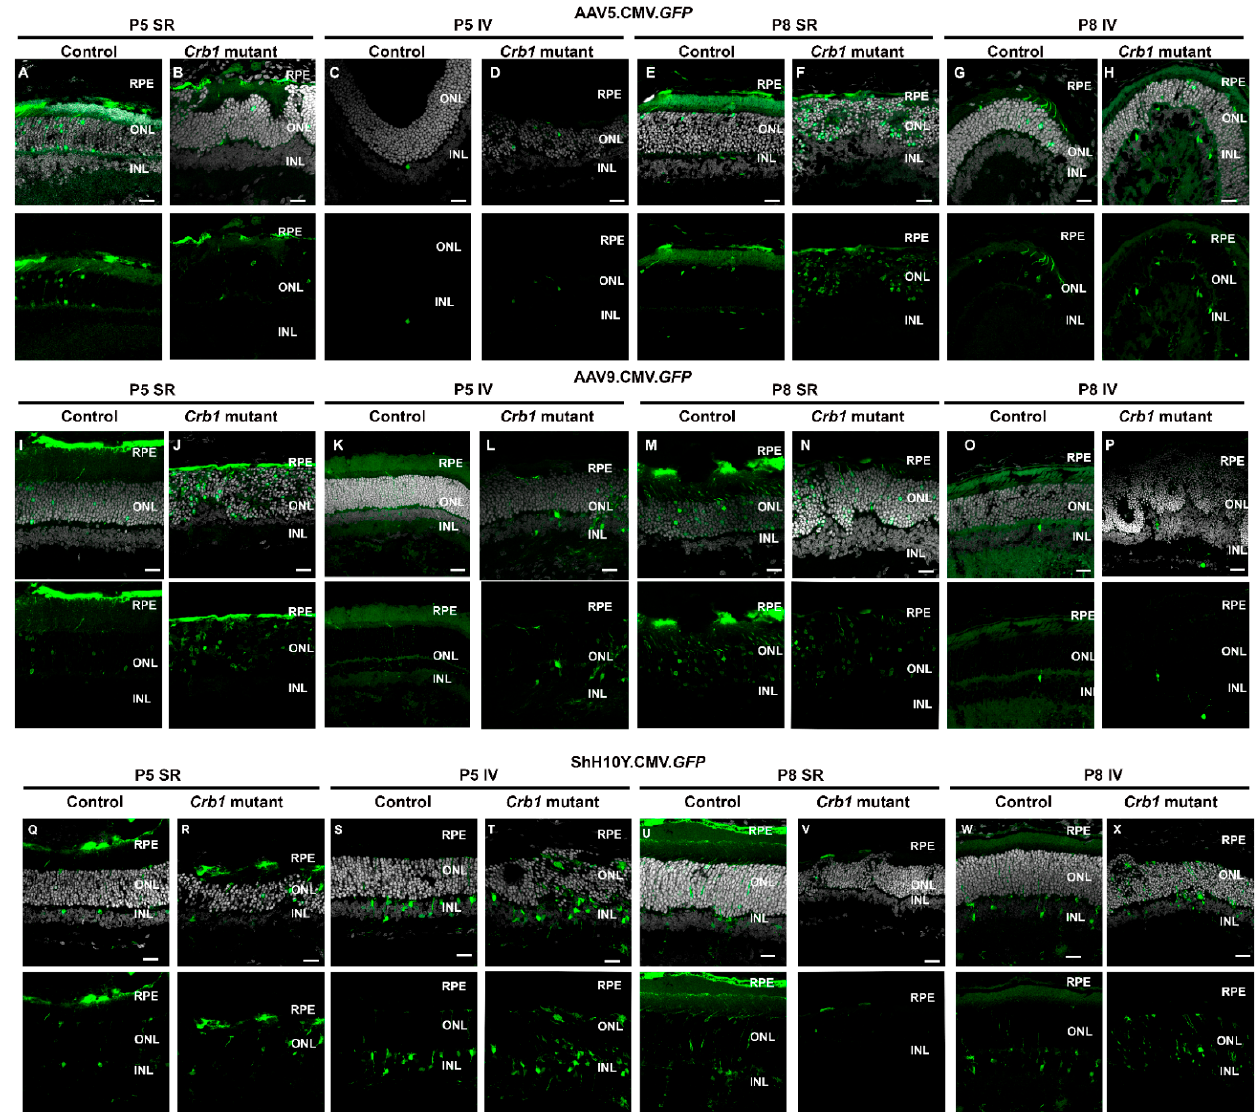
Figure 6. Retinal tropisms of AAV5, AAV9 and ShH0Y in new-born Crb1 mutant and control rat retinas. P5 or P8 control and Crb1 mutant rats were injected subretinally (SR) or intravitreally (IV) with either AAV5-, AAV9- or ShH10Y.CMV. GFP and analyzed at 1 month of age. Tropism studies show that SR injection of AAV5 and AAV9 mainly infect RPE and photoreceptors at P5 ( A , B , I , J ); similar results were obtained when injected at P8 ( E , F , M , N ). IV injection at P5 of AAV5 and AAV9 show mainly infection of sporadic photoreceptors and some INL cells ( C , D , K , L ); similar results were obtained when injected at P8 ( G , H , O , P ). SR injection of ShH10Y at both P5 and P8 in control and Crb1 mutant retinas results in infection of RPE, photoreceptors and INL cells ( Q , R , U , V ); analysis of IV injection of ShH10Y at both P5 and P8 show transduction of INL cells ( S , T , W , X ). For each serotype and route of delivery, a dose of ~1x10 13 gc/mL was injected in a volume of 1 µL. Scale bar: 20 µm. Number of animals analyzed: AAV5 control P5 SR n = 6, P5 IV n = 2, P8 SR n = 2, P8 IV n = 2, AAV5 Crb1 mutant P5 SR n = 4, P5 IV n = 3, P8 SR n = 2, P8 IV n = 5; AAV9 control P5 SR n = 3, P5 IV n = 2, P8 SR n = 3, P8 IV n = 3, AAV9 Crb1 mutant P5 SR n = 4, P5 IV n = 3, P8 SR n = 2, P8 IV n = 3; ShH10Y control P5 SR n = 2, P5 IV n = 6, P8 SR n = 2, P8 IV n = 5, ShH10Y Crb1 mutant P5 SR n = 3, P5 IV n = 4, P8 SR n = 2, P8 IV n = 3.